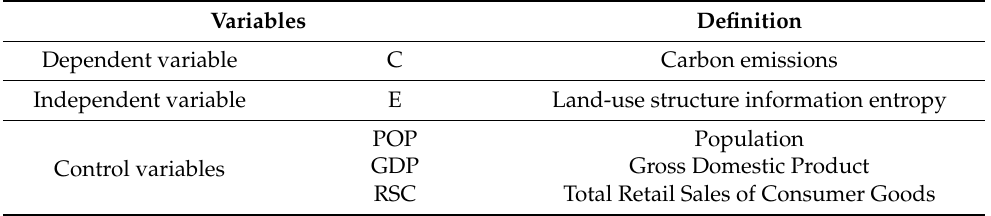
Table 2. Descriptive of